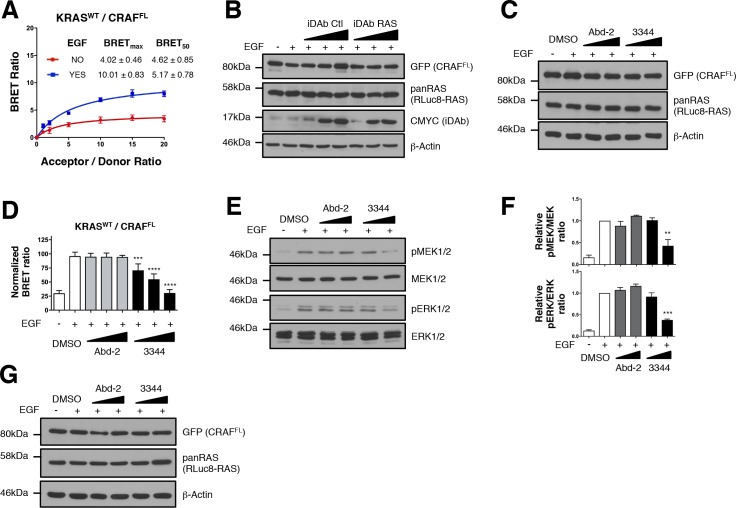
3344 inhibits KRASWT/CRAFFL interaction induced by EGF treatment.(A) BRET titration curves of KRASWT with CRAFFL. After EGF stimulation (50 ng/mL), KRASWT contacts CRAFFL as indicated by an increase of the BRETmax value. (B) Controls from Figure 3B. The expression level of the BRET pair was assessed with the GFP (for CRAFFL) and pan-RAS (for RLuc8-KRASWT) antibodies. iDAb expression is revealed by the CMYC tag antibody; anti-β-actin binding was used as the loading control. (C) Controls from Figure 3E. The expression level of the BRET pair was assessed with the GFP (for CRAFFL) and pan-RAS (for RLuc8-KRASWT) antibodies. Anti-β-actin binding was used as control. Panel D shows the short-term effect on BRET2 signal of compounds Abd-2 (grey bars) and 3344 (black bars) on KRASWT/CRAFFL interaction after EGF treatment in a BRET competition experiment (3 hr incubation of the compounds). In panel E, HEK293T cells were transfected with the plasmids expressing the BRET pair KRASWT/CRAFFL for 24 hr, serum starved 24 hr and then incubated for 3 hr with DMSO, 10 and 20 μM of Abd-2 and 3344 compounds. Cells were treated 5 min with EGF (50 ng/mL), lysed and analysed by western blot. Quantification of panel E is shown in panel F. (G) Controls from panel E. One-way ANOVA followed by Dunnett’s post-hoc tests were used to determine the statistical significance of BRET, pERK and pMEK modulations induced by the compounds (**p<0.01, ***p<0.001, ****p<0.0001). Each experiment was repeated twice (A, E–F) or three times (D). Where error bars are presented, they correspond to mean values ± SD of biological repeats (A, D) or correspond to mean ± SEM of biological repeats (F).